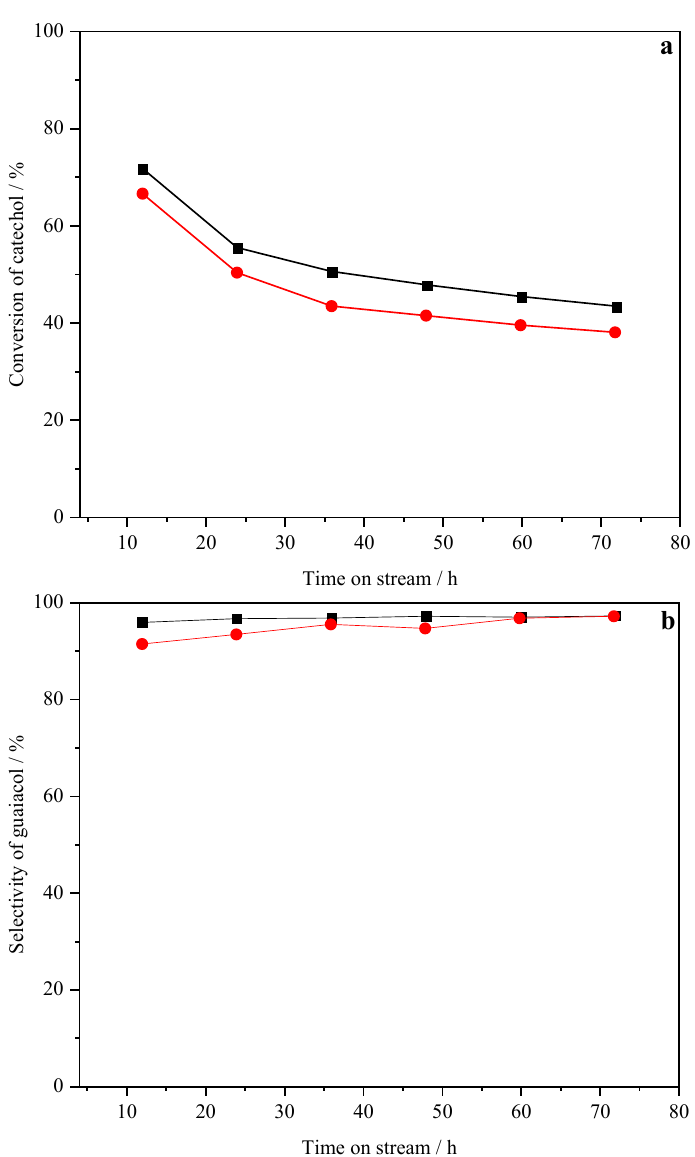
Figure 7. Catechol conversion ( a ) and guaiacol selectivity ( b ) of CP catalyst in cycle experiment, ( ■ ) the first cycle, ( ● ) the second cycle.